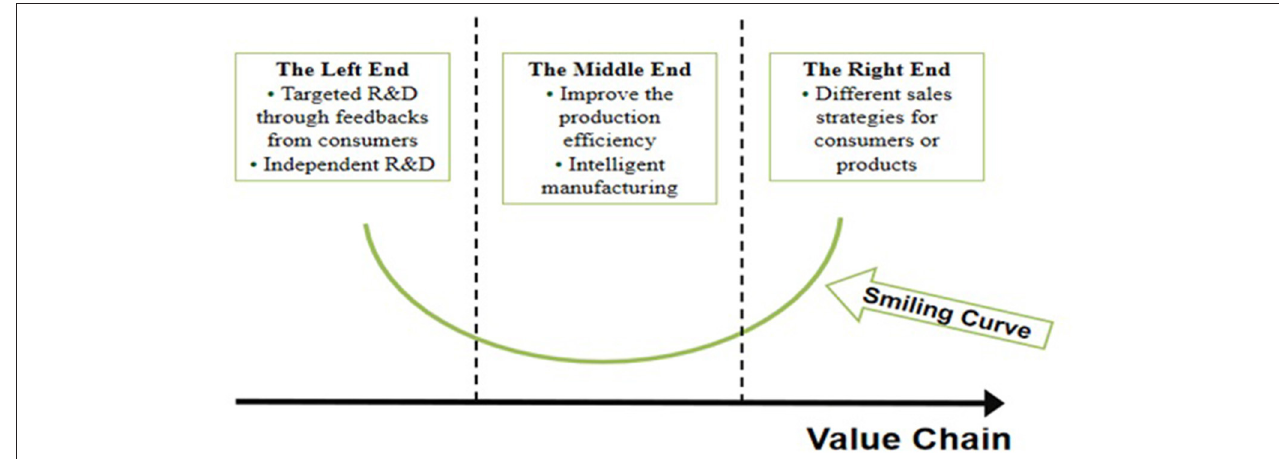
FIGURE 1 | Six scenarios obtained by combining the corporate smiling curve with the value